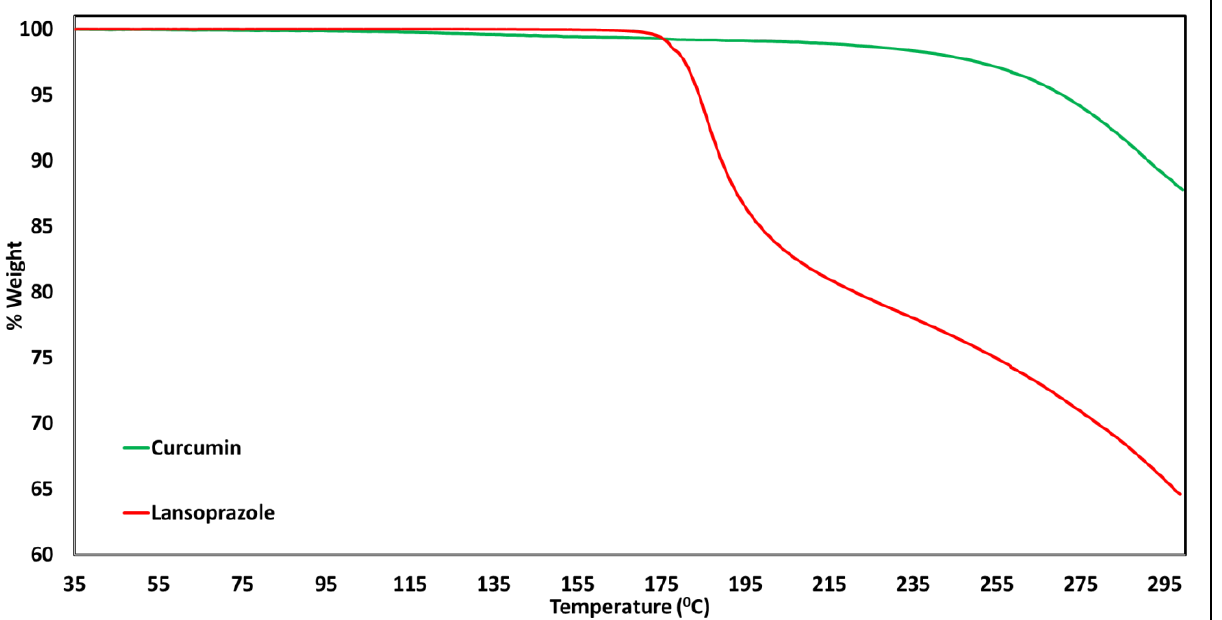
Figure 5. Thermogravimetric analysis of curcumin and lansoprazole pure drugs.